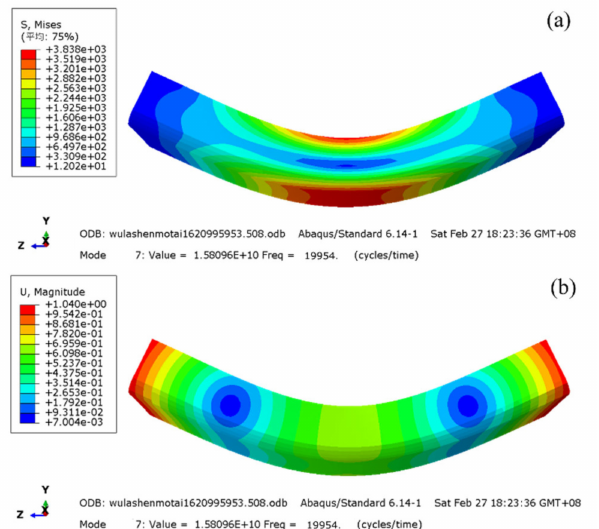
Figure 3. Modal analysis nephogram of equiaxial I. ( a ) Stress distribution; ( b ) displacement distribution.